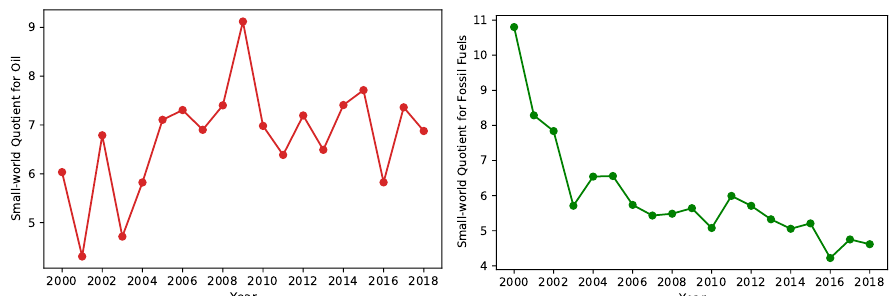
Figure 6. The evolution of small-world coefficient for oil ( left ) and the INEF ( right